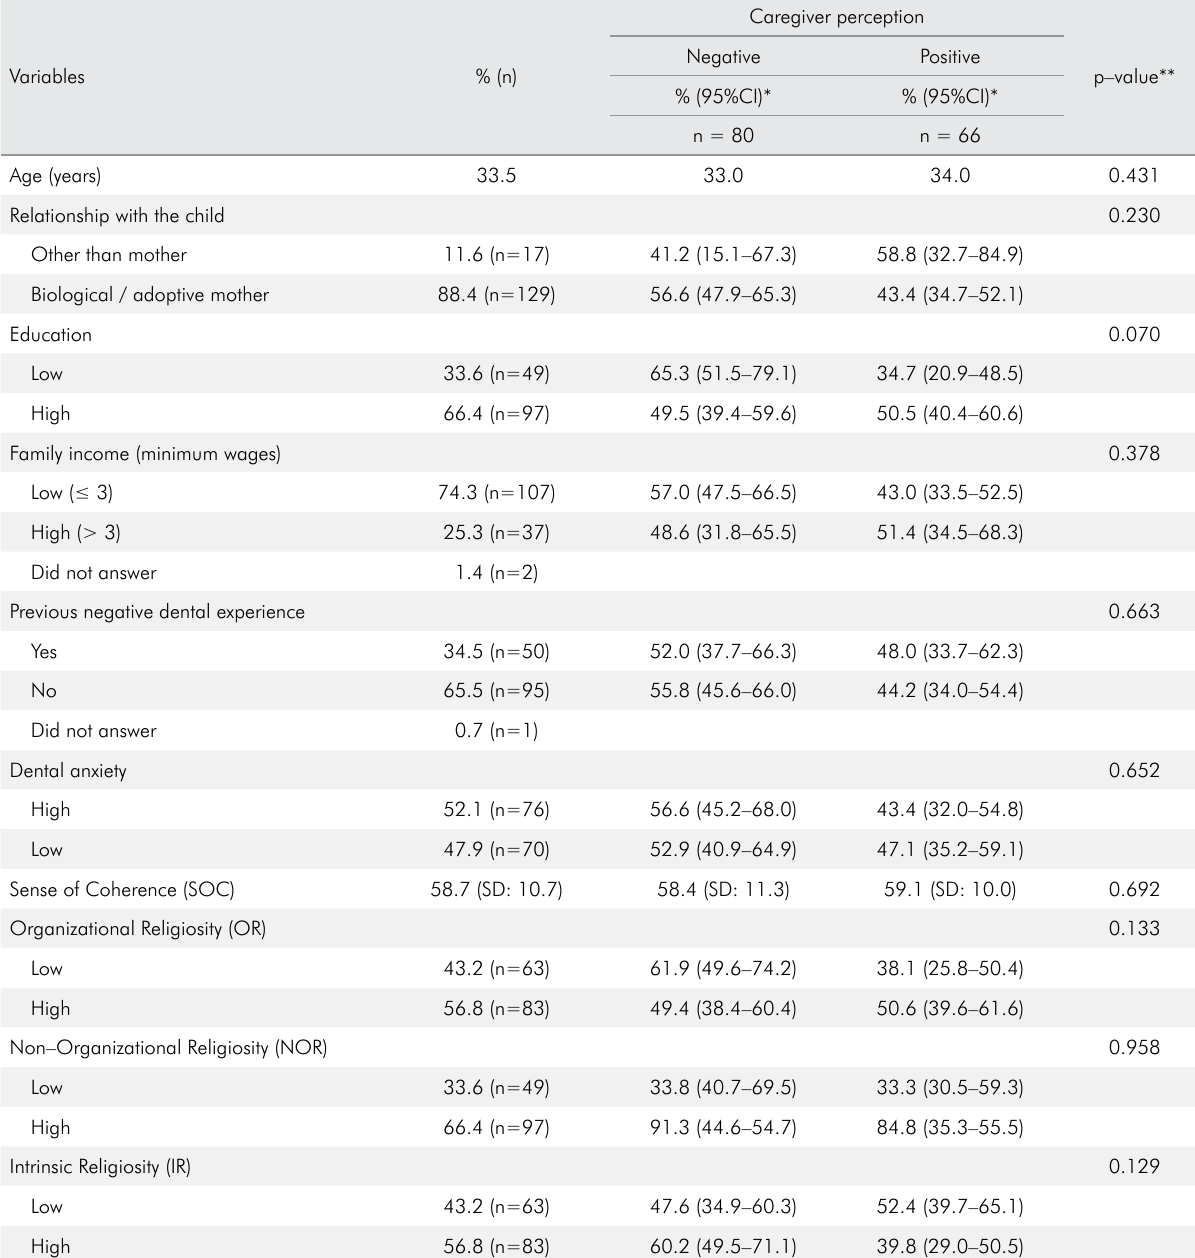
Table 1. Frequency distribution and bivariate analysis of the association between caregivers’ perception of children’s dental health and the caregivers–related independent variables (n =